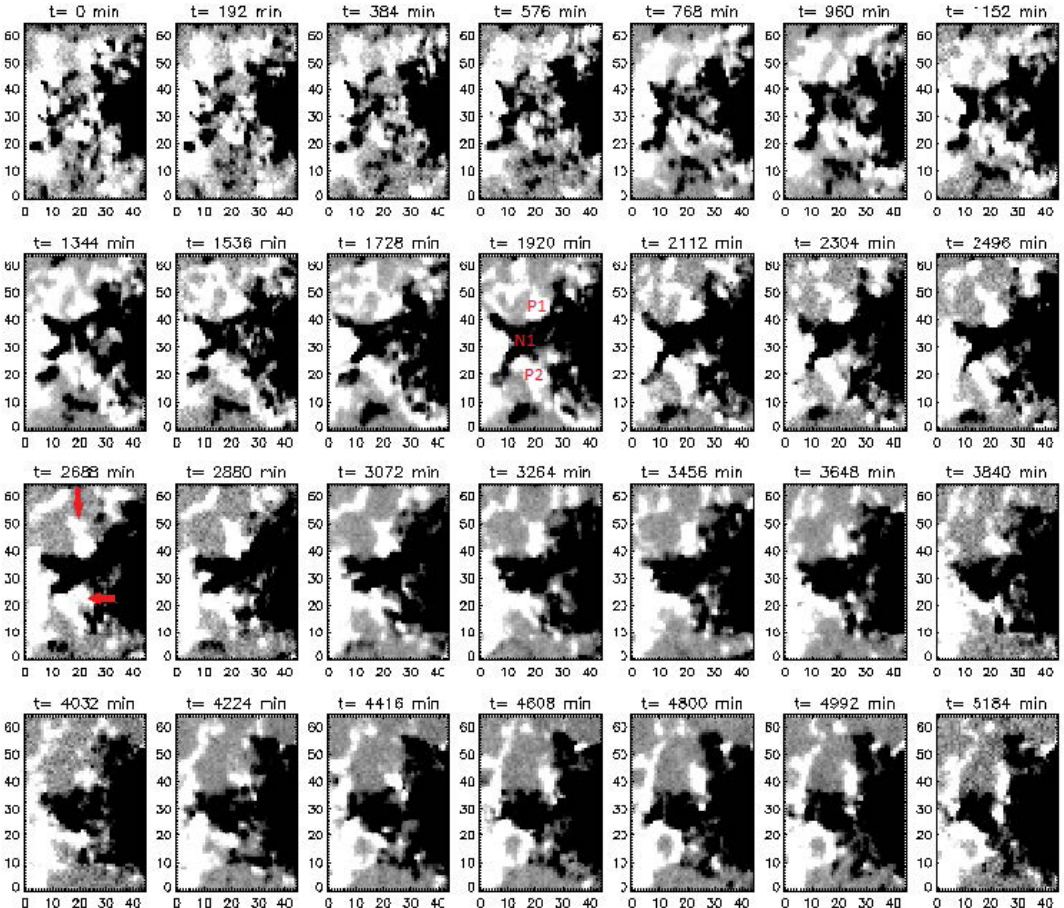
Figure 2. Evolution of the LOS component of the magnetic field around the PIL for the period of 3.6d starting on 31 December 2000 at 01:34:43UT. The x and y axes show the spatial coordinates in pixel values, where each pixel corresponds approximately to